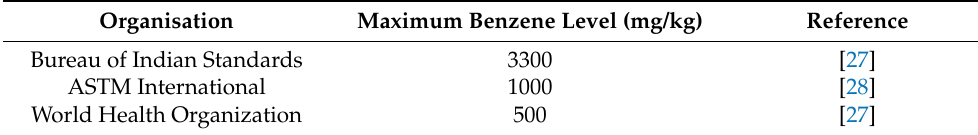
Table 1. Examples of benzene limits recommended in “food grade”